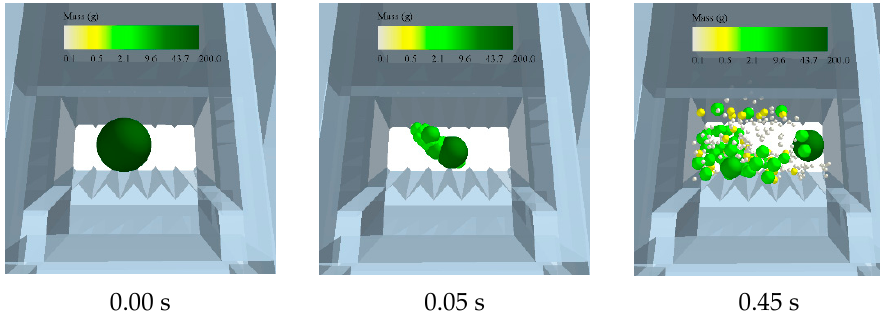
Figure 9. Comparison of experimental and simulated breakage of a single 63/52-mm particle in the jaw crusher chamber.